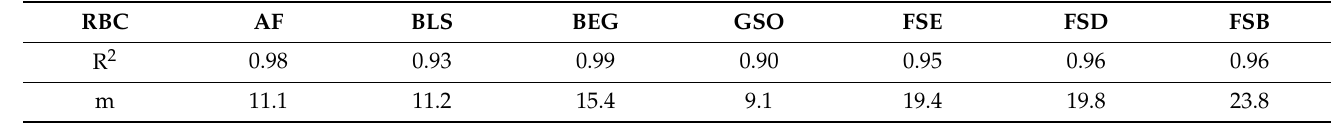
Figure 5. Weibull plot representing the empirical cumulative distribution function of the flexural strength data in the materials: ( a ) Admira Fusion; Beautifil LS; Brilliant EverGlow; and Grandio SO, and ( b ) Filtek Supreme XTE Enamel; Supreme XTE Dentin; and Supreme XTE Body.